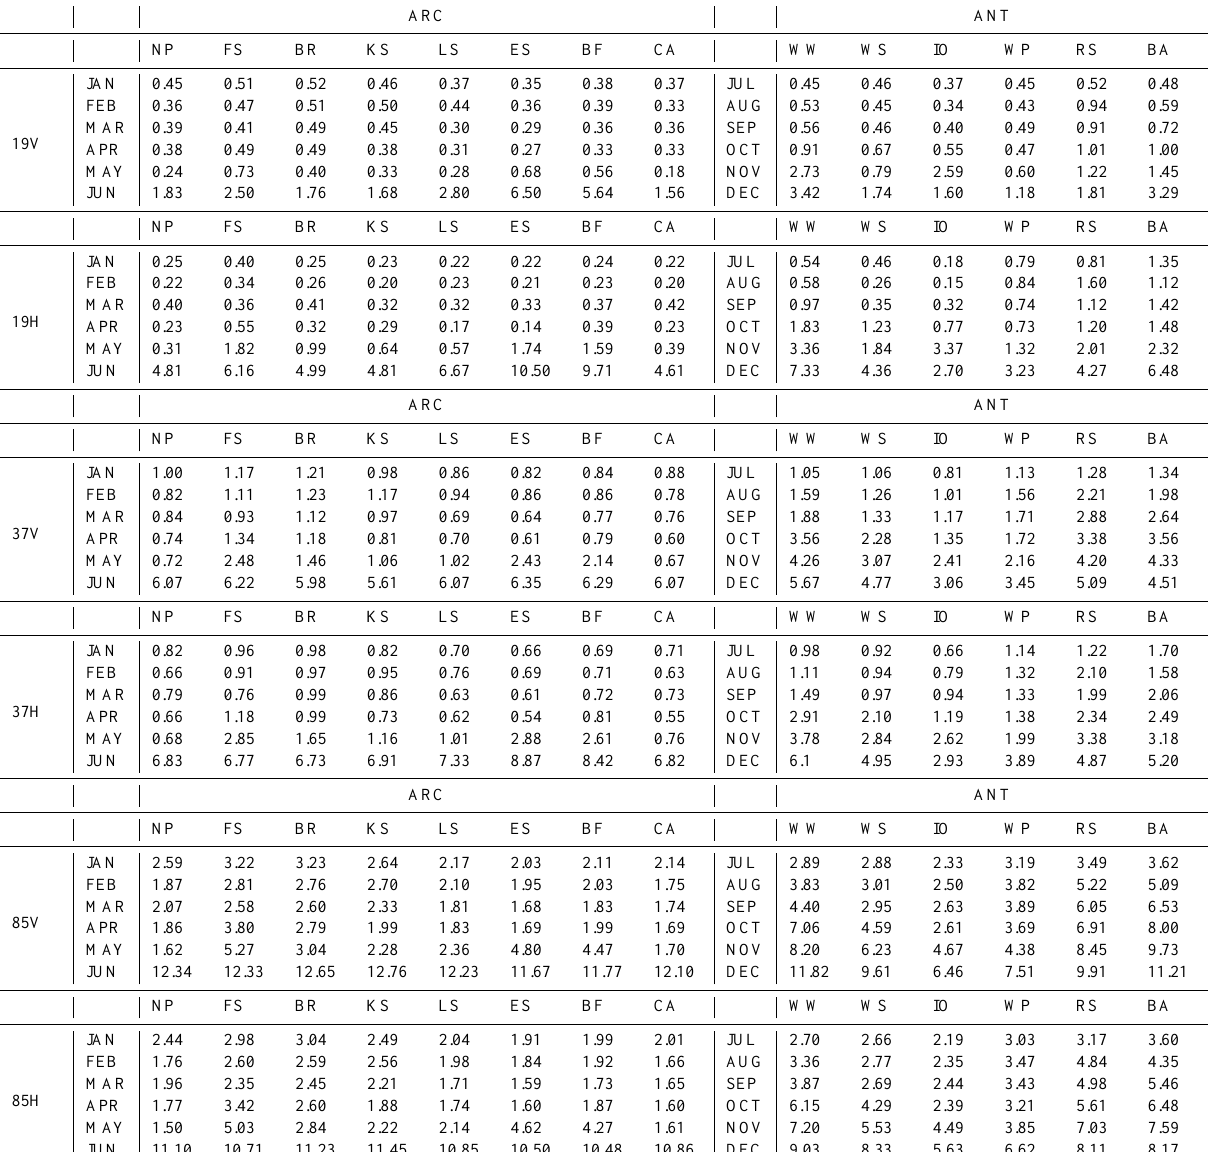
Table 2. Monthly standard deviation of emissivity (here: 0–100%) per region, month, frequency and polarization.